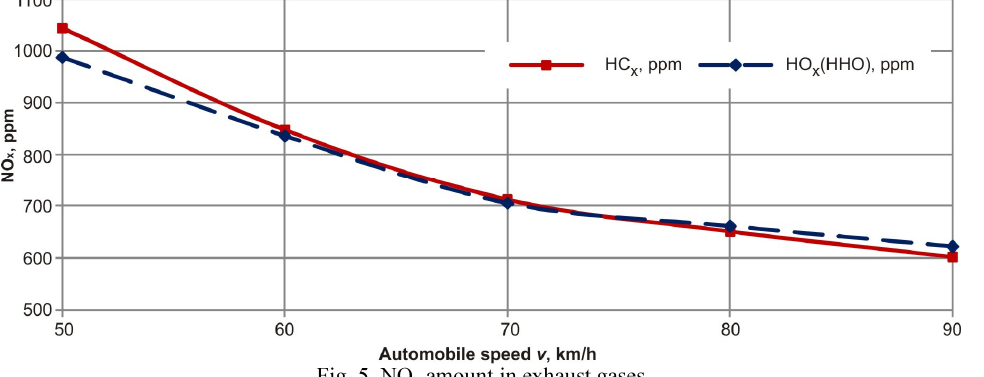
Fig. 5. NO x amount in exhaust gases